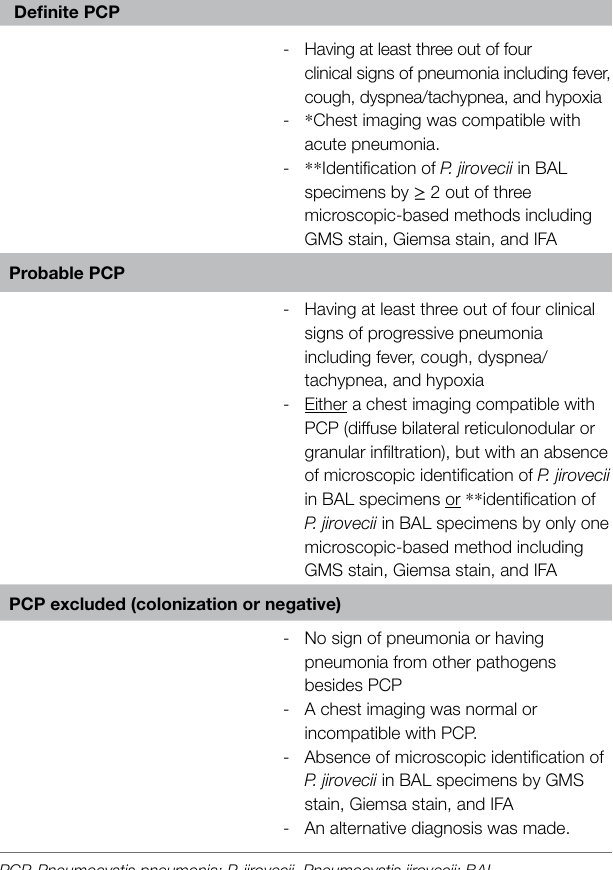
TABLE 1 | Criteria used for diagnosis definition. Mandatory criteria must be met for each diagnosis. Definite